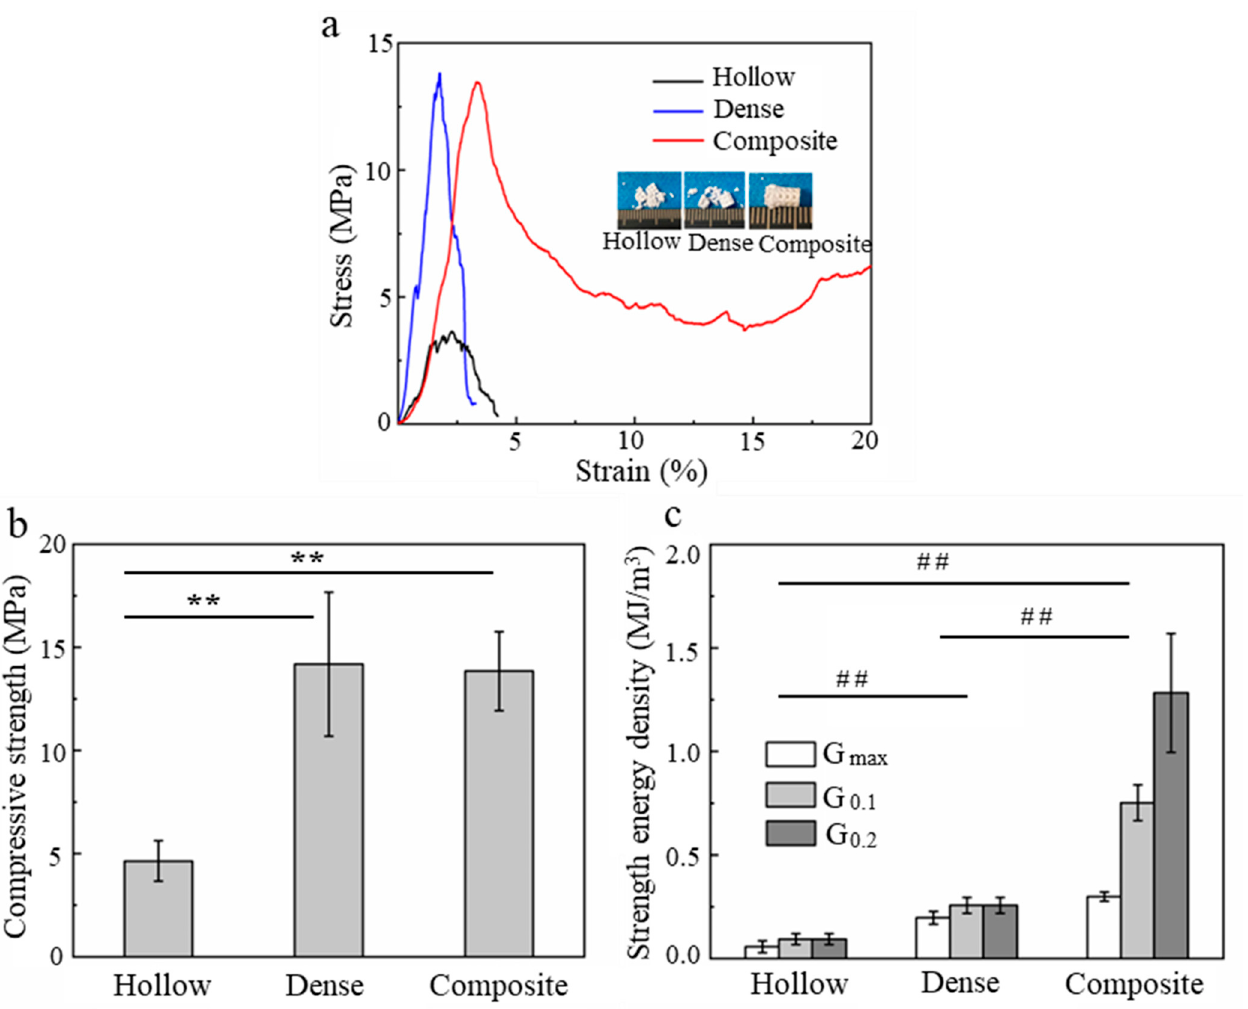
Figure 7. ( a ) Representative uniaxial compressive stress-strain curves ( b ) compressive strength ( c ) strain energy density for the different scaffolds. (Data presented are the mean ± standard error of the mean, n = 5, ** ## p < 0.01).